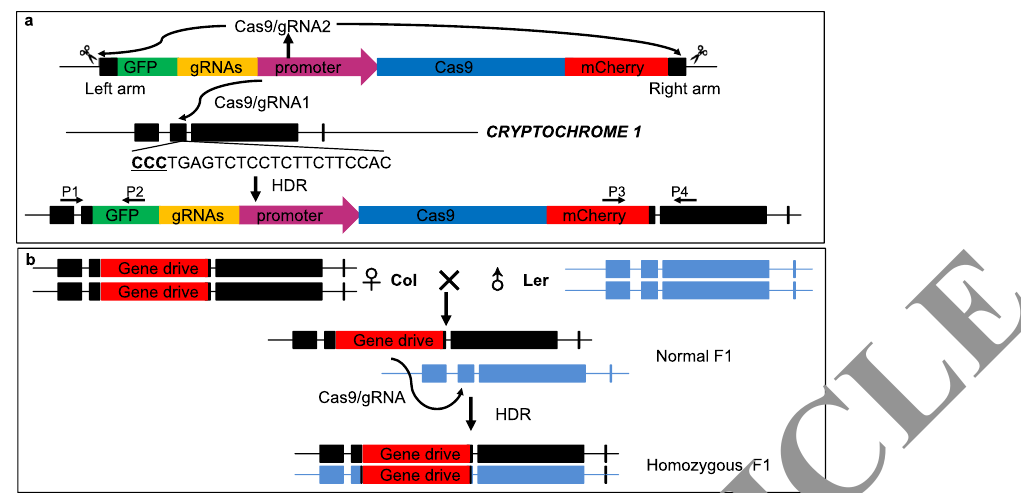
Fig. 1 A CRISPR/Cas9-based gene drive in Arabidopsis converts heterozygous plants into homozygous plants. a A schematic representation of the gene drive that is inserted into the second exon of the CRYPTOCHROME 1 ( CRY1 ) gene on Chromosome IV using CRISPR/Cas9-mediated homology-directed repair (HDR). The gene drive element fl anked with homology arms is released by the Cas9/gRNA2 complex, which is produced by the Cas9 and gRNA units on the gene drive. The gene drive element has several components: a Cas9 -expressing unit, two gRNA units (one targeted CRY1 and the other was used to release the HDR template from the plasmid). The GFP gene is designed to fuse with part of CRY1 in frame, providing a visual marker for precise